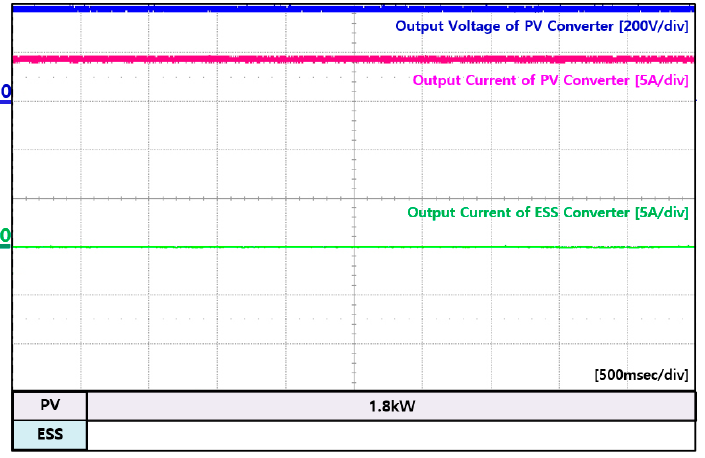
Figure 32. Experiment waveforms of DC load and multi-level inverter in mode 6.